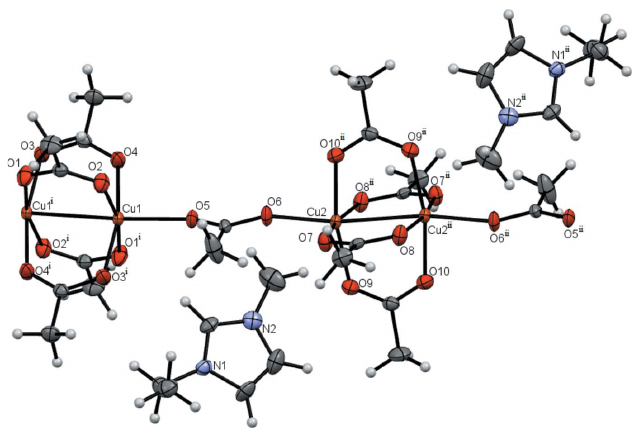
Figure 3 Compound 3 with displacement ellipsoids drawn at the 50% probability level. [Symmetry codes: (i) 2 (cid:2) x , 2 (cid:2) y , 2 (cid:2) z ; (ii) 1 (cid:2) x , 2 (cid:2) y , 1 (cid:2) z